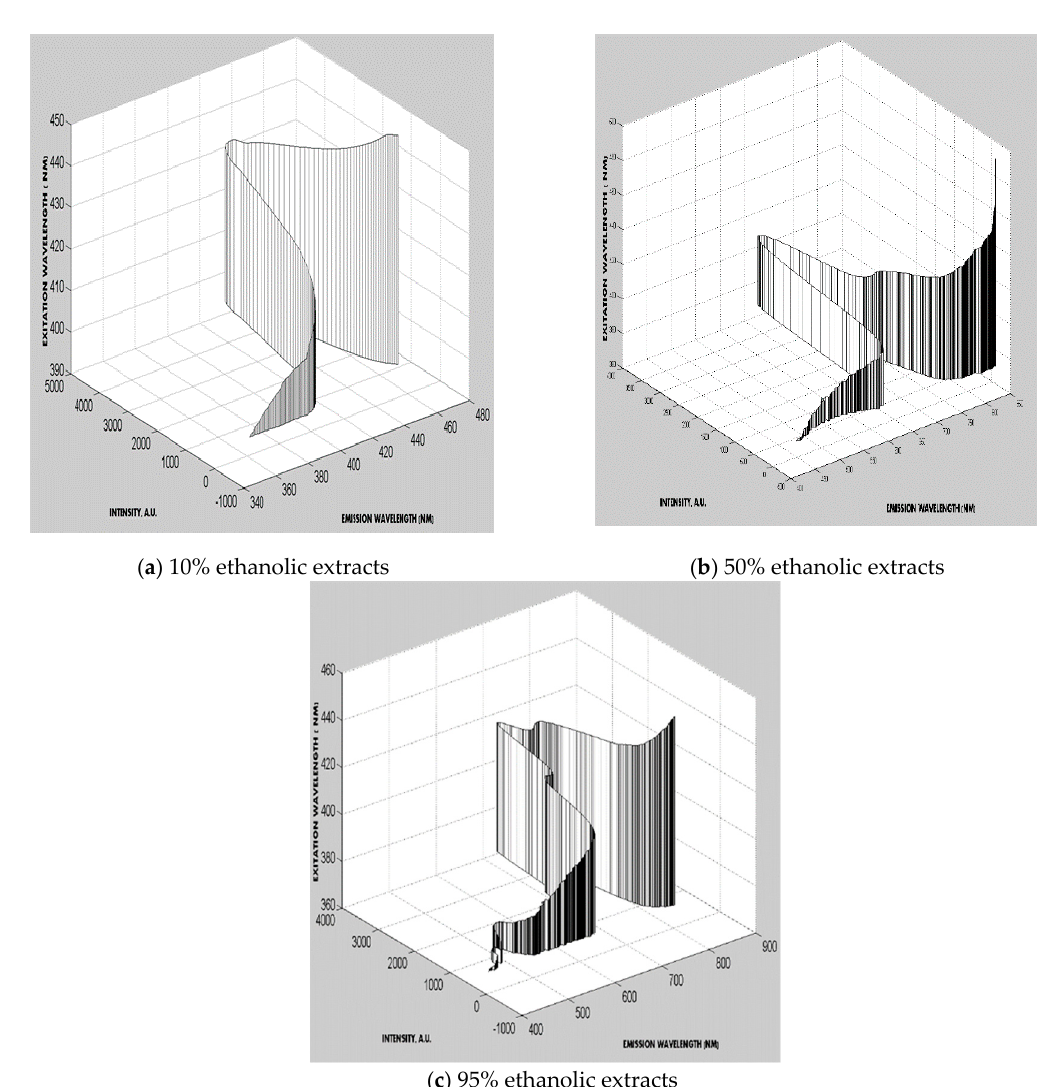
Figure 4. Excitation-emission matrices of ethanolic extracts of Sempervivum tectorum L. ( a ) 10%; ( b ) 50%; ( c ) 95%. The contents of essential and toxic elements in three extracts were determined by ICP-MS. Results are presented in Table 4. Ethanol, % Table 4. Concentrations of essential and toxic elements in water-ethanolic extracts (RSD for all samples varied between 2– 7%).